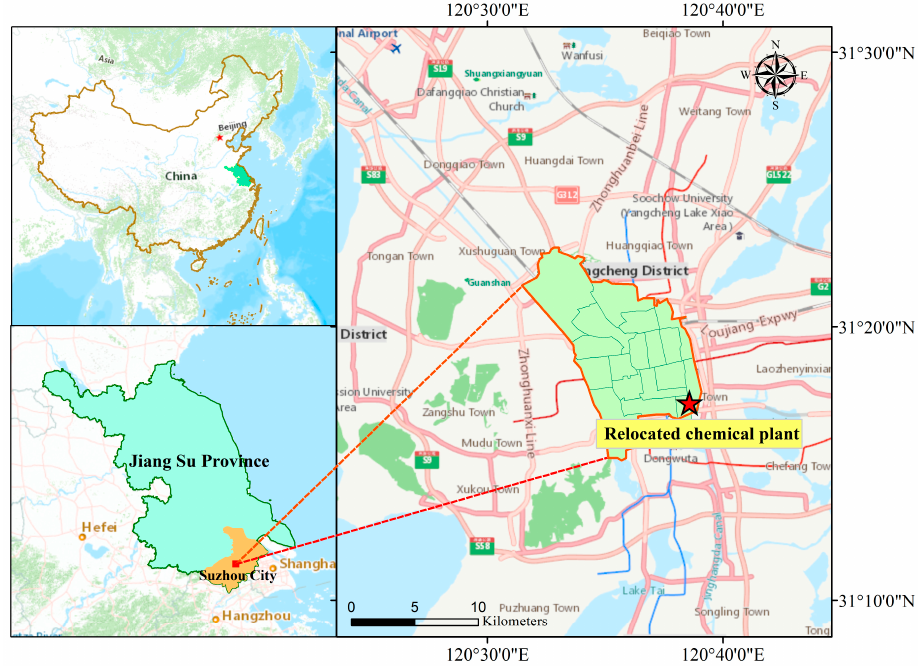
Figure 1. Location of the study area in the city of Suzhou, southeast of the Jiangsu Province of China.